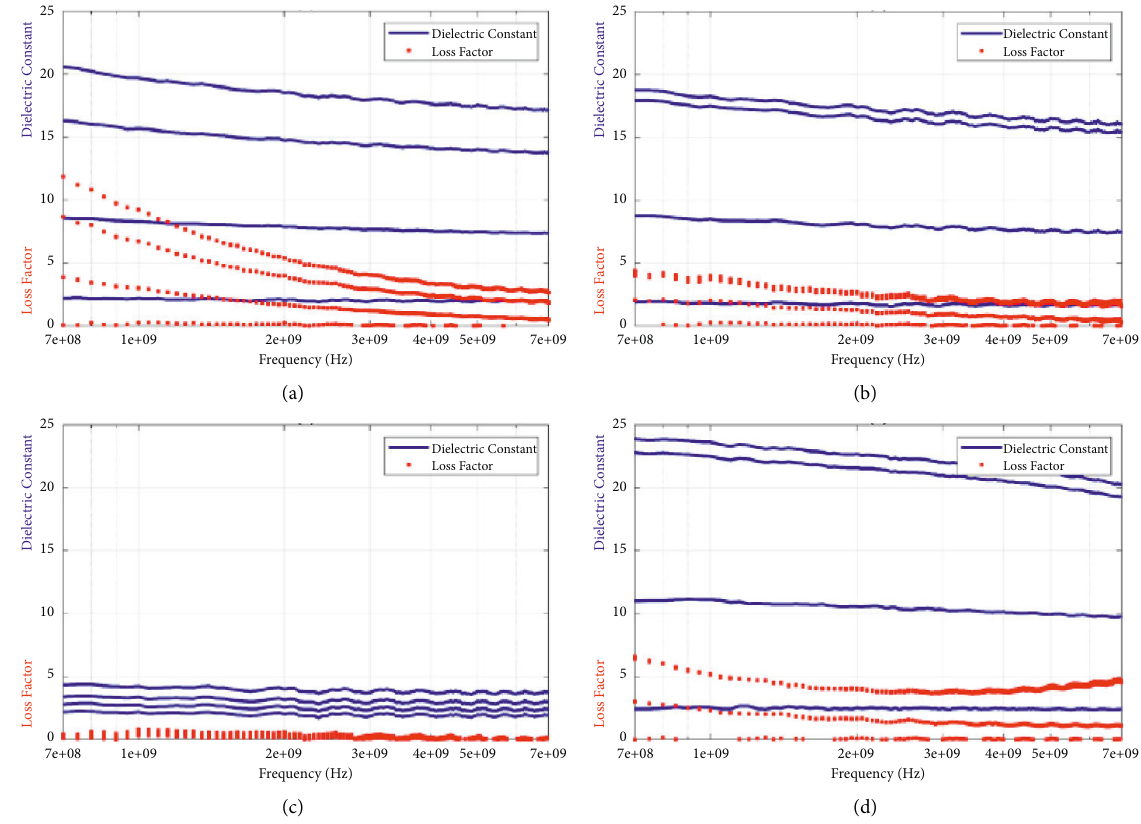
Figure 2: Four soil types were tested for their dielectric characteristics with respect to frequency and moisture presence: (a) JU clay, (b) JU loam, (c) JU frank, and (d) Bangalore clay loam. Table 4: Information about soil moisture state, frequency, and type of soil in relation to dielectric data. Type of